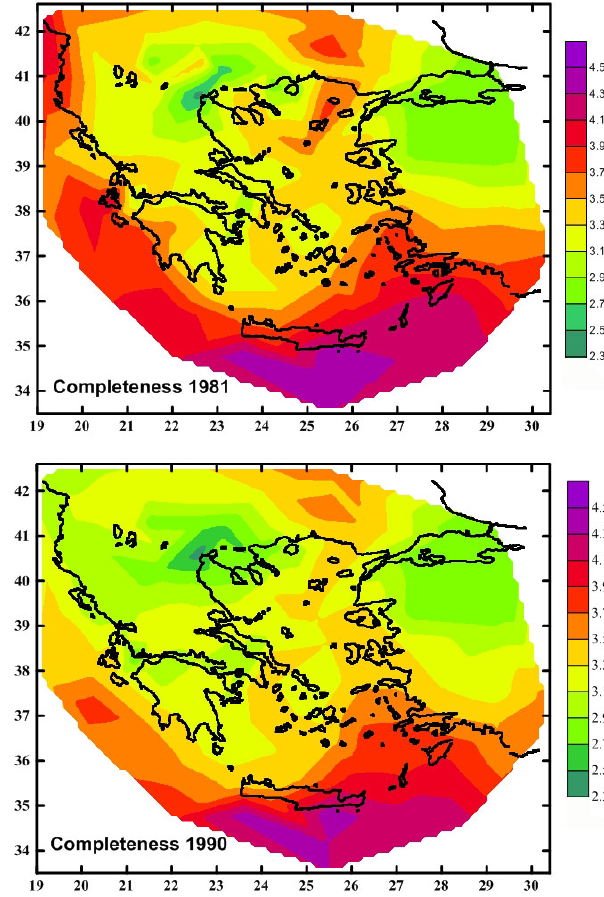
Figure 9. Spatial distribution of completeness magnitude, M C , for the periods 1981–2008 (top) and 1990–2008